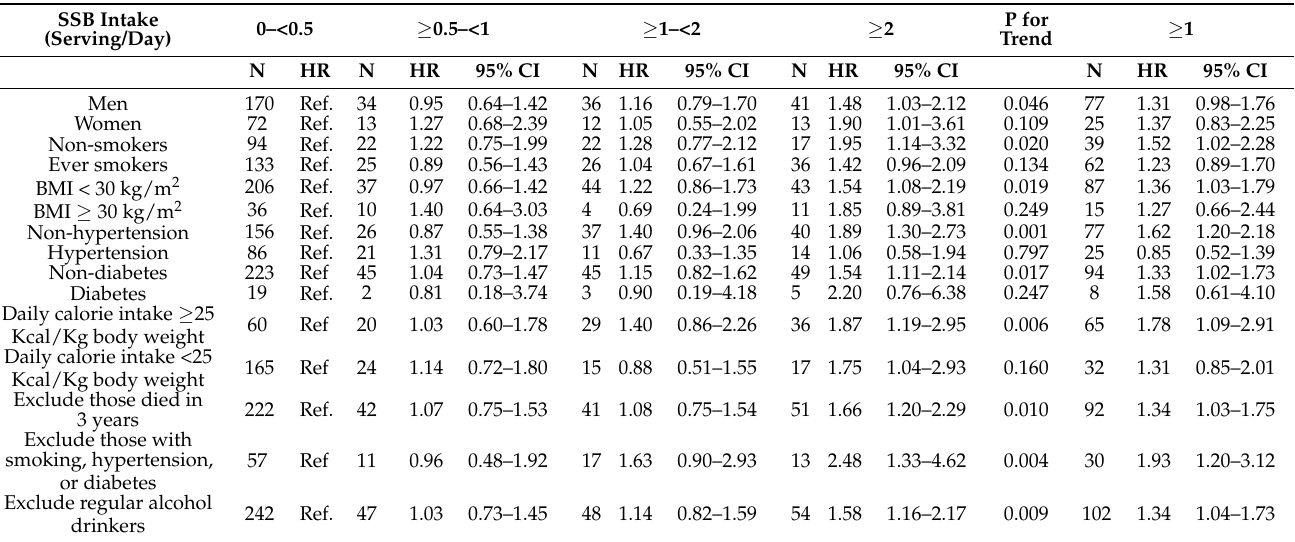
Table 3. Sensitivity analyses for the mortality risks of cardiovascular diseases by levels of sugar- sweetened beverages